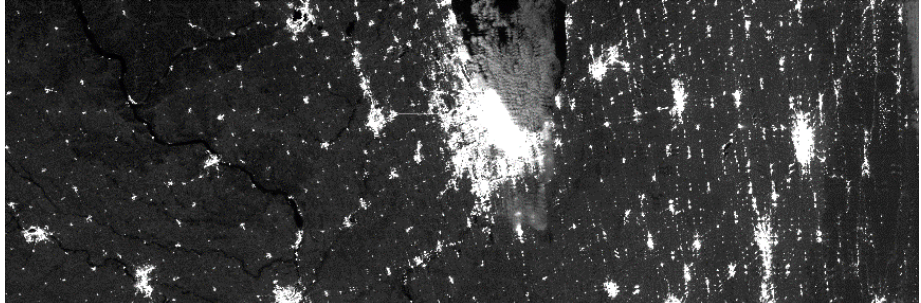
Figure 13. Reprocessed NOAA-20 VIIRS DNB nighttime image recorded over the Midwestern United States at 8:56 UTC, October 24, 2018. The 288 × 864 (track × scan) pixels are in the upper right side of the granule. The updated NOAA-20 VIIRS DNB LGS Gains LUT and the NOAA-20 VIIRS DNB Gain Ratios LUT created by the linear regression method were used for reprocessing.